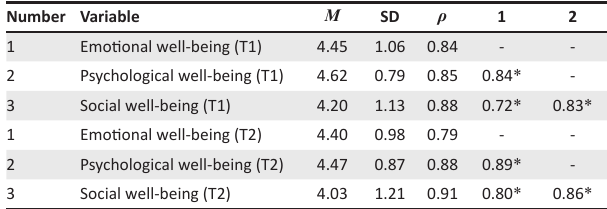
TABLE 2: Means, standard deviations, reliability coefficients and correlations.